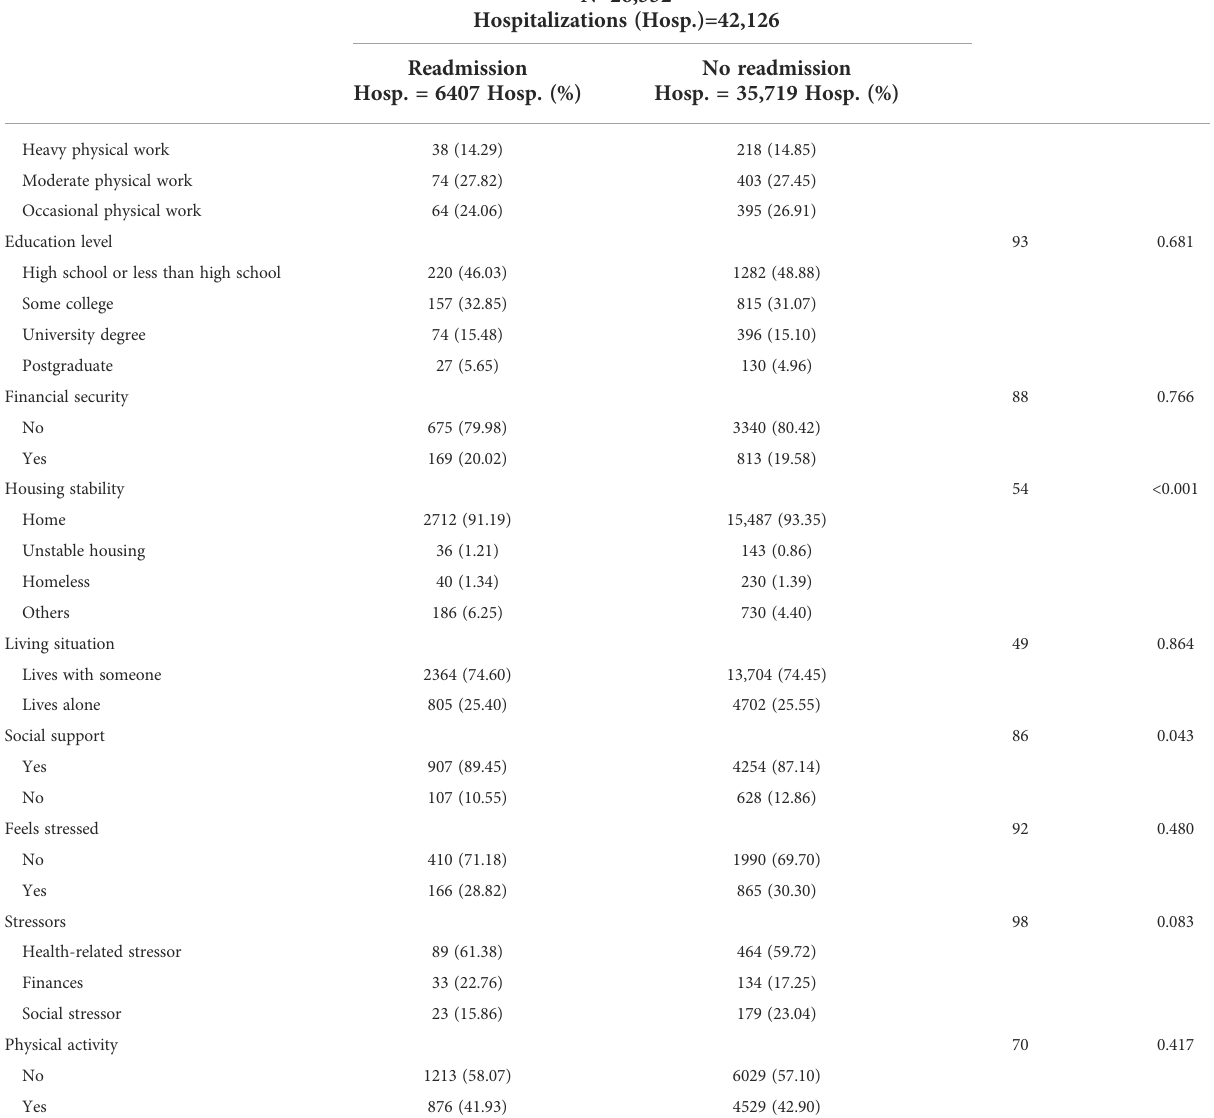
The adjusted odds for the multivariable logistic regression models without and with social needs are presented in Table